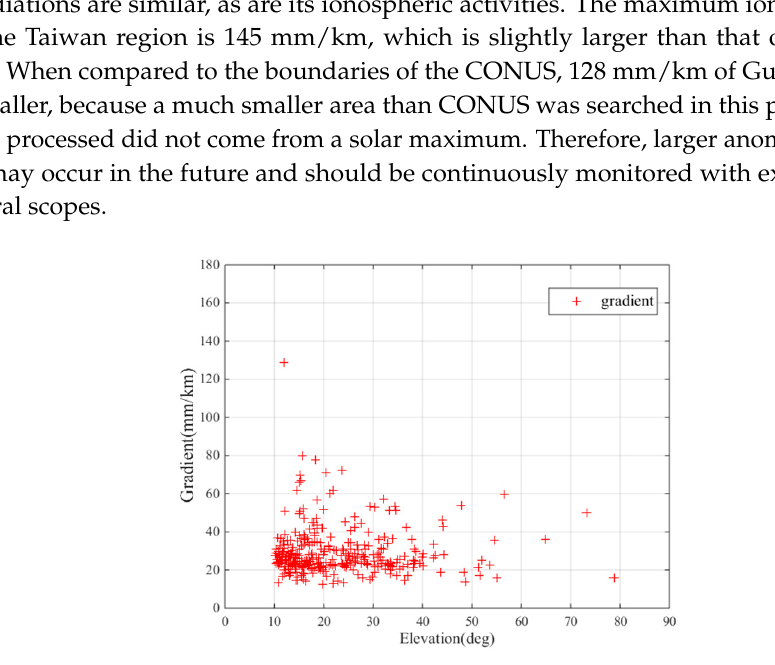
Figure 10. Ionospheric gradient model: ionospheric gradients observed over Guangdong.